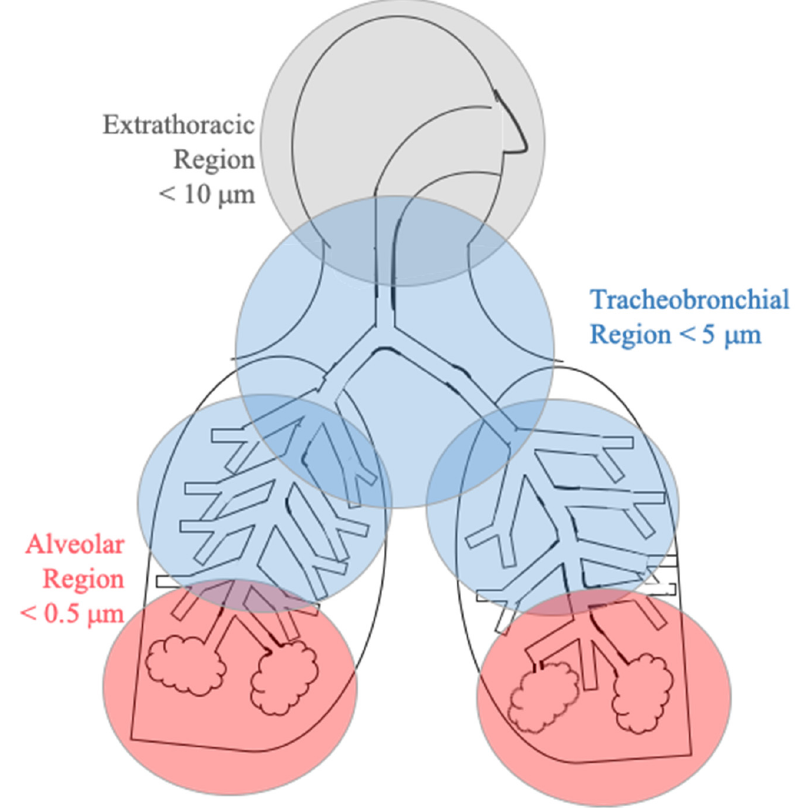
Figure 1. Diagram of regions of interest in the respiratory tract. The extrathoracic (ET) region is shaded in gray, the tracheobronchial (TB) region is shaded in blue, and the alveolar (AL) region is shaded in red. The indicated sizes are an approximation, and the actual sizes of penetrating particles depend on a person’s physiology, breathing patterns, and other variables.